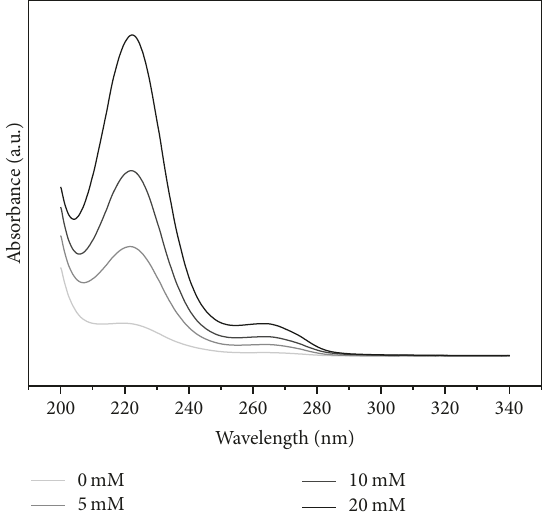
Figure 3: UV-Vis spectral changes in terbuthylazine upon addition of different concentrations of HP- 𝛽 -CD at 25 ± 2 ∘ C: (— light gray) 0 mM; (— gray) 5mM; (— dark gray) 10mM; and (— black) 20 mM.